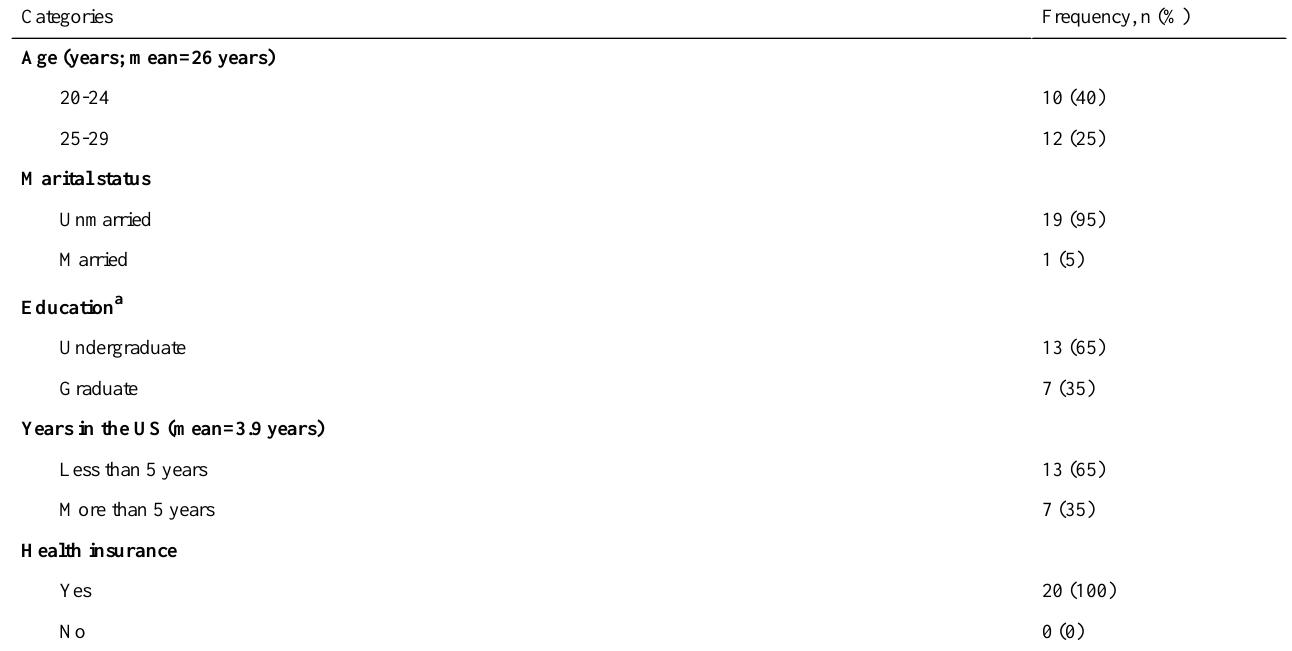
Table 1. Sociodemographic characteristics of the sample